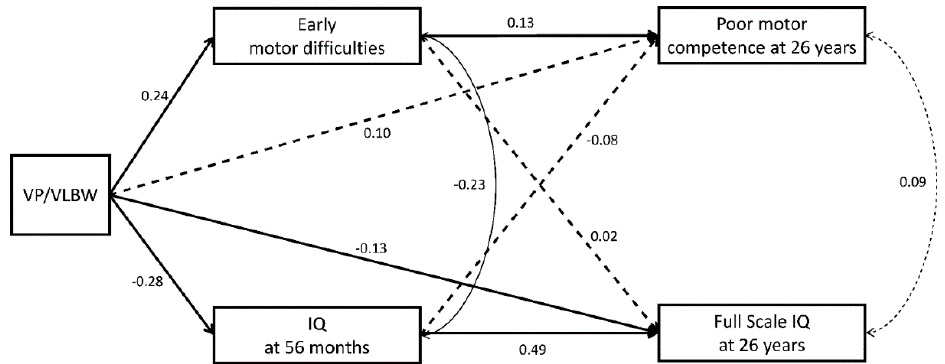
Figure 3. Structural equation model showing direct and indirect e ff ects of VP / VLBW and early motor trajectories (di ffi culties) on motor competence and IQ at 26 years (excluding participants with neurological impairment, Model 2). Bold lines represent hypothesized e ff ects, solid lines represent Figure 3 . Structural equation model showing direct and indirect effects of VP/VLBW and early motor significant e ff ects, and dashed lines represent non-significant e ff ects (standardized regression coe ffi cients trajectories (difficulties) on motor competence and IQ at 26 years (excluding participants with β ). E ff ects of interest are shown. E ff ects of covariates and error terms are not presented to enhance neurological impairment, Model 2). Bold lines represent hypothesized effects, solid lines represent readability. For e ff ects of confounds see Table significant effects, and dashed lines represent non-significant effects (standardized regression